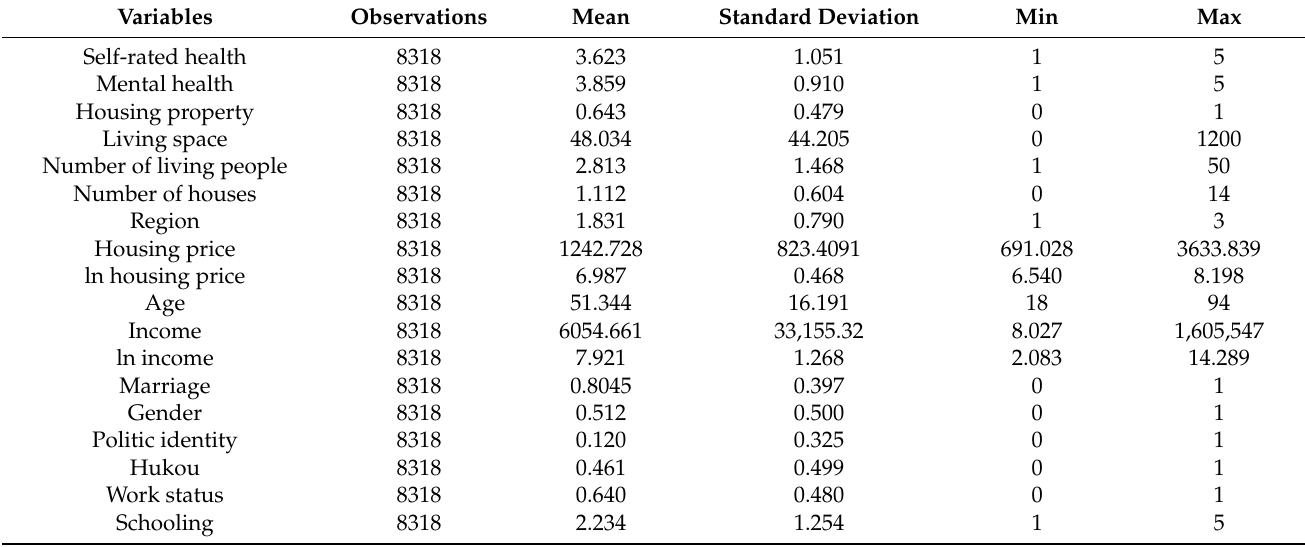
Table 1. Descriptive statistics of respondents’ demographic variables and housing factors.